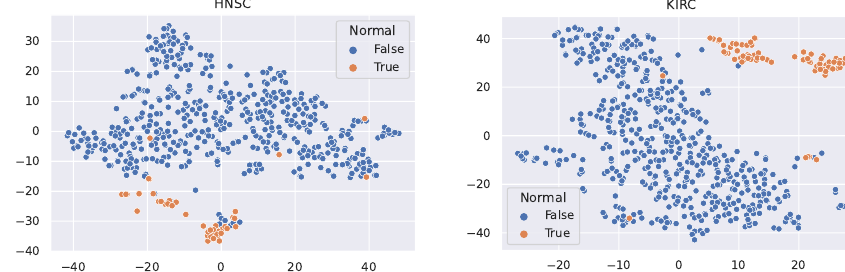
Figure 4. t-SNE visualisation of HNSC and KIRC.